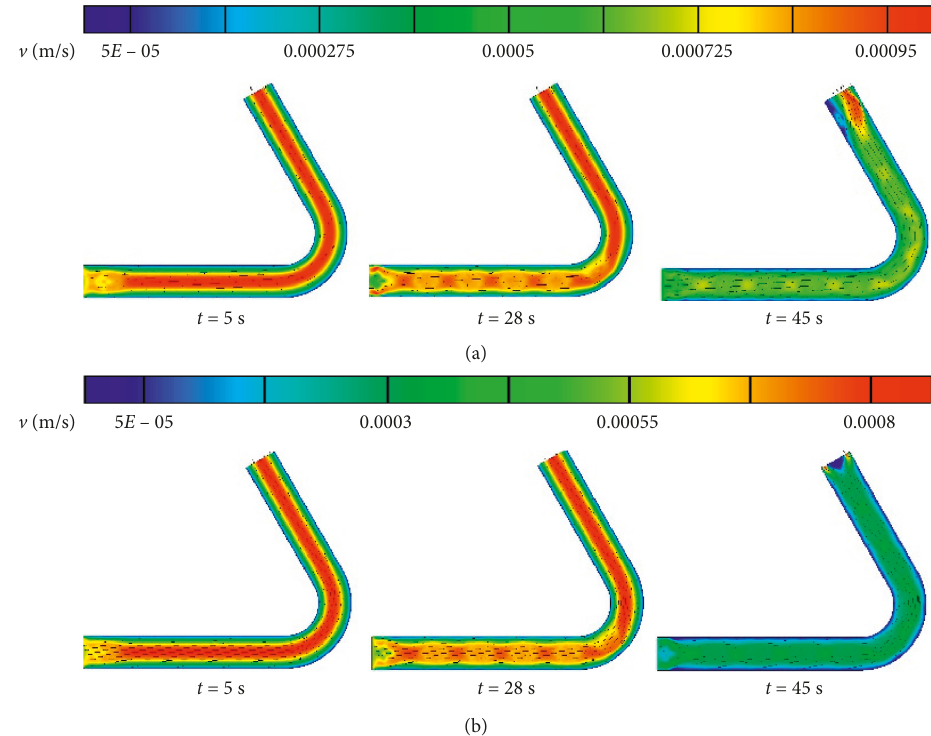
Figure 8: Effect of capillary number on the velocity distribution during compound droplet deformation: (a) Ca � 0.05; (b) Ca � 0.025.